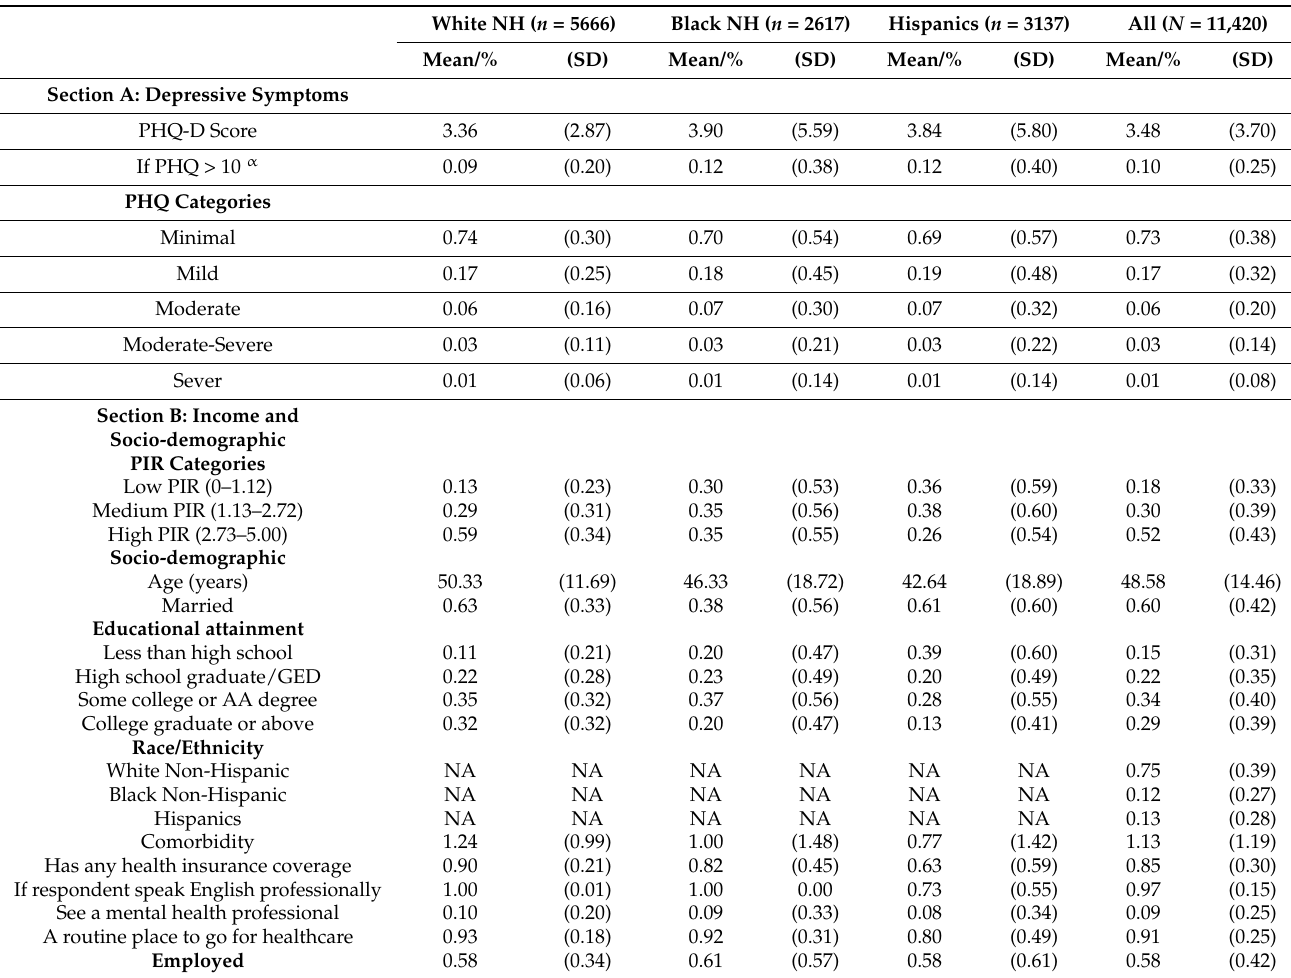
Table 1. Demographic Characteristics of US Women Aged 20 and Above; NHANES